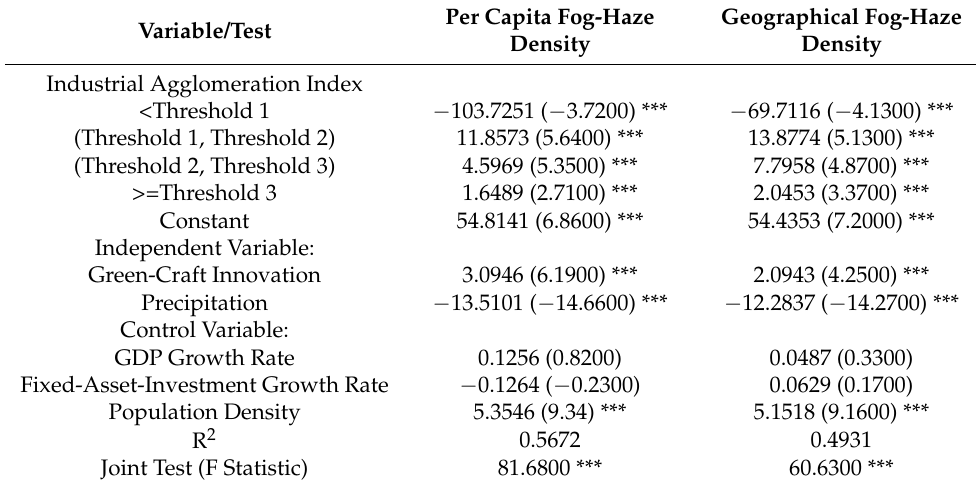
Table 9. Regression estimation results of threshold